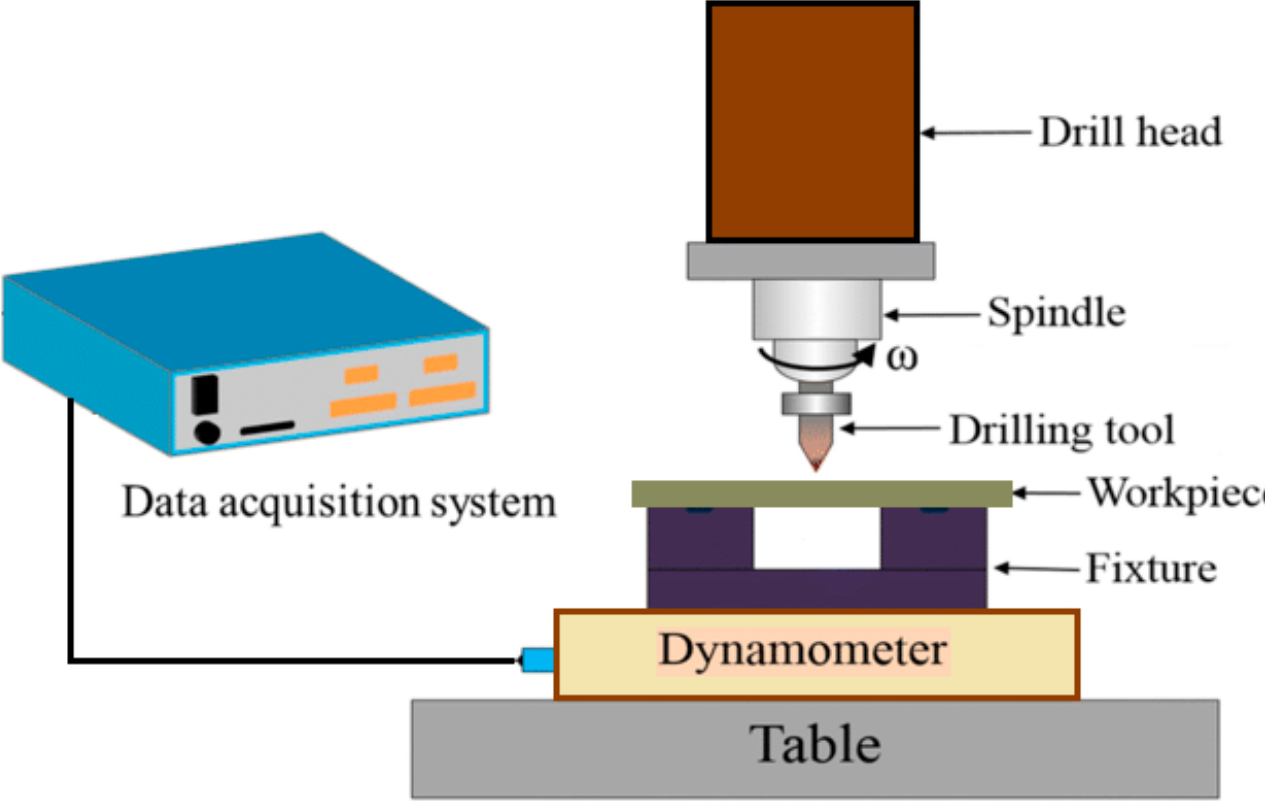
Figure 2. Experimental setup.